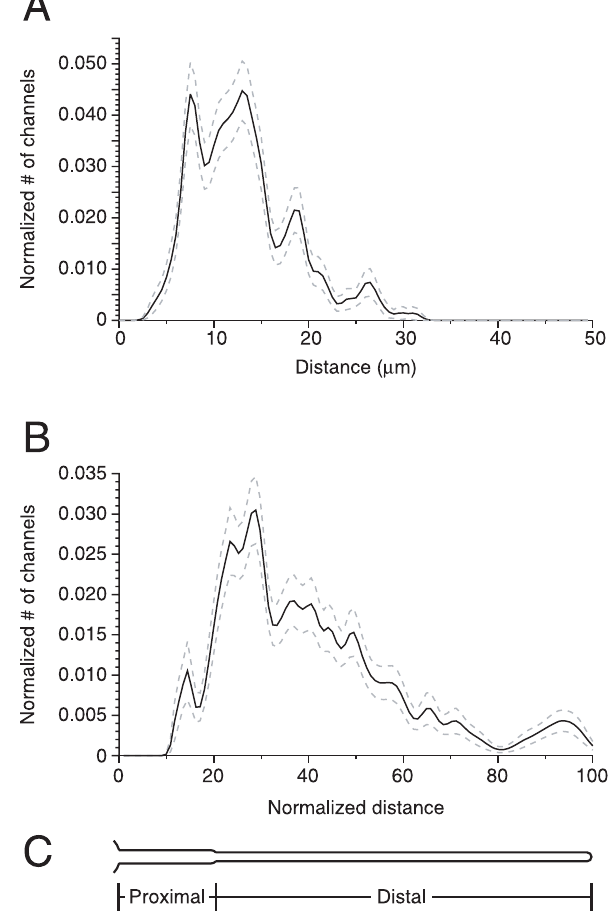
Figure 5. Average channel density function. (A) By inverse solution, channel density functions (e.g. Fig. 2B) were generated from each of 239 recordings from 59 different cilia. The black line shows the average density function; the dashed gray lines represent the standard errors. Recordings made under all of the Ca 2 + -buffering conditions described for Fig. 4 were included in the average. Each channel density function consisted of 111 points evenly spaced along the length of the cilium. Before averaging, each function was scaled to a total integrated area of 1.0. Thus the y -coordinate represents the fraction of the total channels in each of the 111 distance bins. Ciliary length averaged 36 6 1 m m (range 18 to 78 m m). On average, the inverse solutions reported 4040 6 260 channels per cilium (range 710 to 27930 channels per cilium). The peak of the inferred Gaussian channel distribution was on average 13.1 6 0.3 m m from the base of the cilium (range 3.6 to 31.2 m m), and the width of the peak was 2.8 6 0.01 m m (range 2.3 to 3.2 m m). The width was determined at the points where the height of the density function was 10% of the peak height. (B) As in (A), but each channel density function was also scaled to an arbitrary length of 100. (C) Schematic of an olfactory cilium showing the proximal and distal segments as described by Reese [11], plus a piece of the dendritic knob at the far left. The relative diameters are drawn to scale. The length is scaled to match the distance axis in (B). The model assumes constant values for the many parameters used (listed in Table S2 of Text S1). However, many of these values are associated with experimental errors. To determine how reasonable errors in some of these values affect the predictions of the model, we applied sensitivity analysis. For each of five parameters, three values were assumed as described in the legend